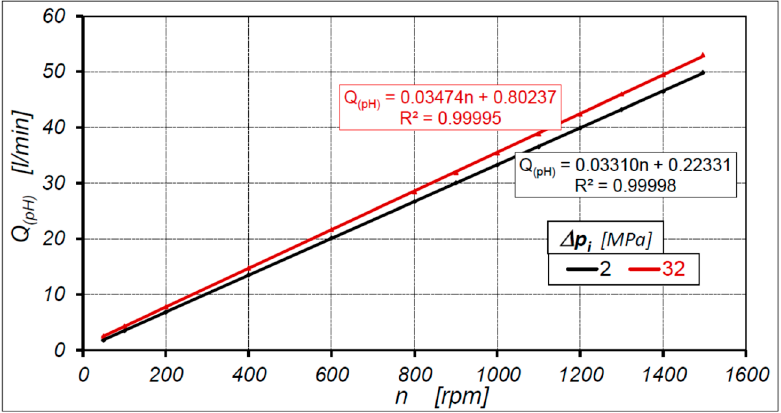
Figure 12. Characteristics of Q ( pH ) = f ( n ) at ∆ pi = const. related to the pressure in the high-pressure working chamber [12].